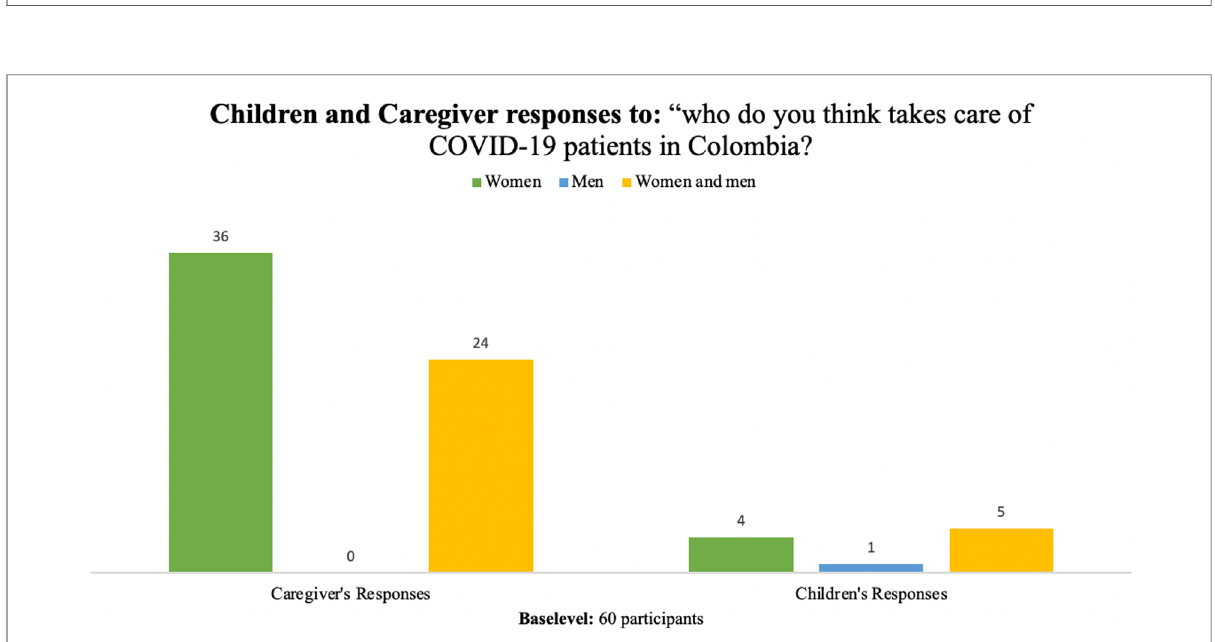
FIGURE 5 Work modality by caregivers.